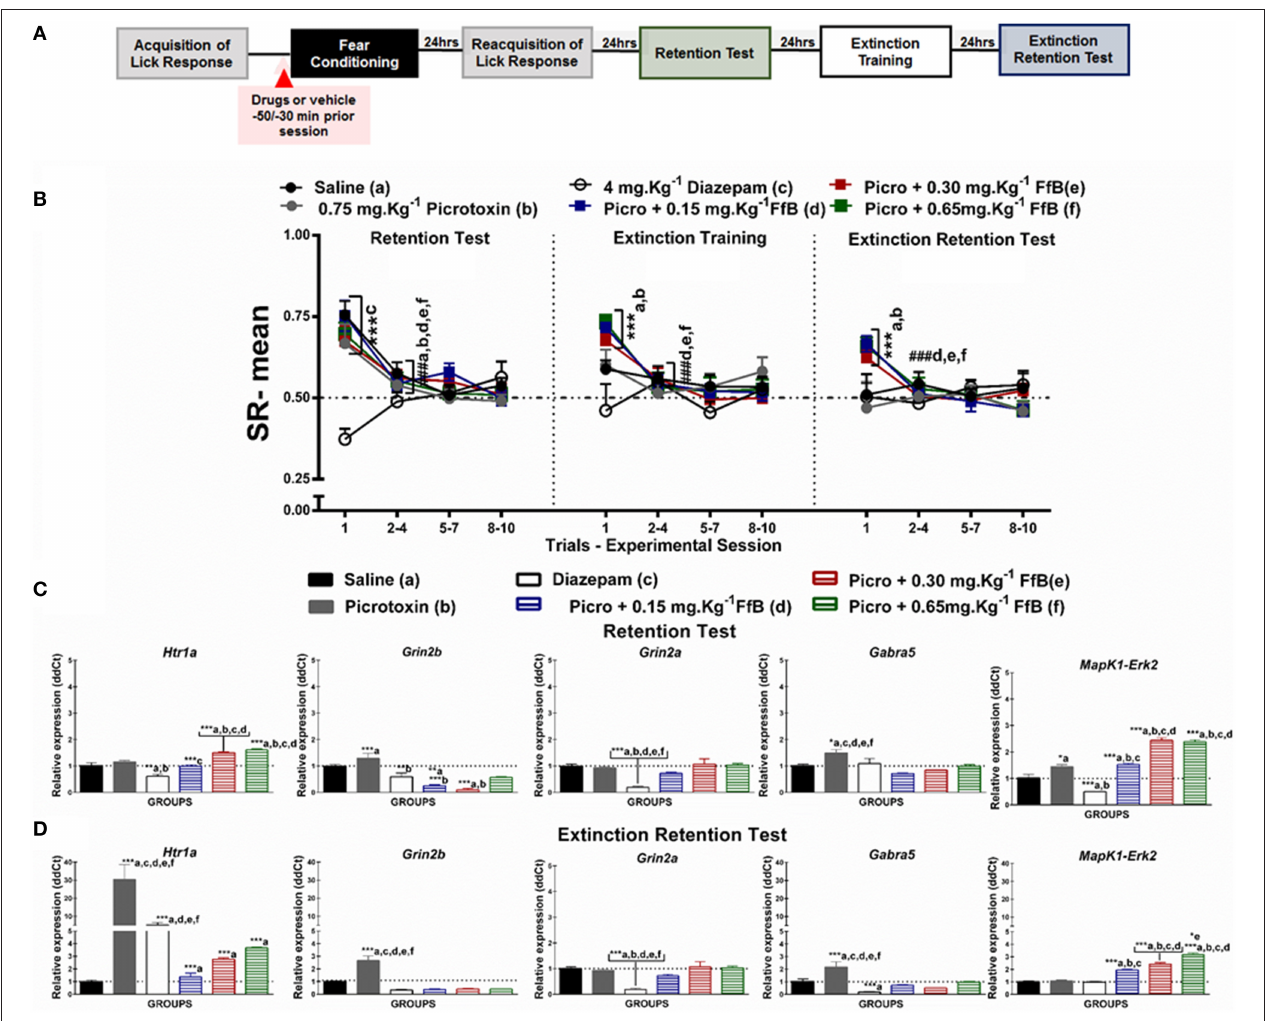
FIGURE 5 | (A) Timeline illustrating the time points of drug administration and brain removal. (B) Mean SR of licking behavior in the test session (8 th day, n = 20 /group), extinction training (9 th day, n = 10 /group), and the extinction retention test (10 th day, n = 10 /group). The first point indicates the mean SR of the 0.9% saline, 0.75mg.Kg − 1 picrotoxin, 4mg.Kg − 1 diazepam, and 0.75mg.Kg − 1 picrotoxin + FfB (0.15mg.Kg − 1 FfB, 0.30mg.Kg − 1 FfB, or 0.65mg.Kg − 1 FfB)